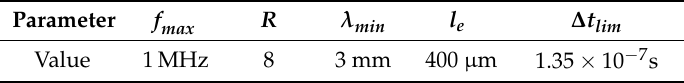
Table 2. Parameters of the finite element calculation.